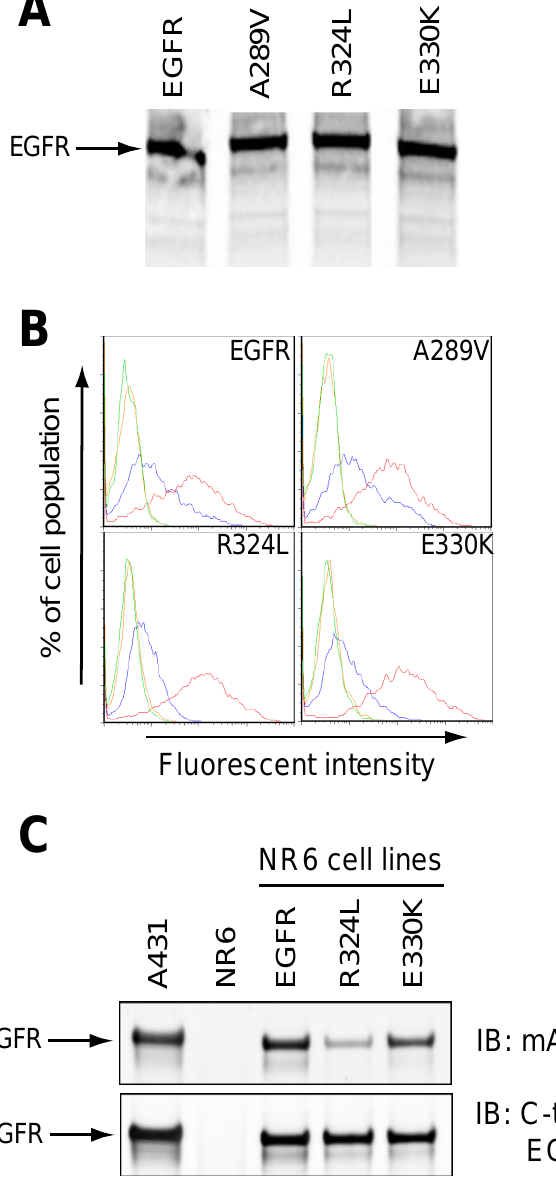
Figure 1. Biochemical characterization of mutant epidermal growth factor receptor (EGFR). ( A ). wtEGFR and mutant EGFR were translated into 35 S-cysteine labelled proteins in a cell free expression system and labeled proteins detected by autoradiography following SDS-PAGE; ( B ). NR6 cells expressing wtEGFR or mutant EGFR were stained with secondary antibody alone (green), isotype control antibody (orange), mAb528 (red) or mAb806 (blue) and subjected to Fluorescence Activated Cell Sorting ( FACS) analysis. The representative profiles for each cell line are shown; ( C ). wtEGFR or mutant EGFR cells were grown under serum free conditions, lysed and IP’d using mAb528. Western blot analysis of total EGFR using a mAb806 probe ( upper panel ) or a C-terminal EGFR probe ( lower panel ) are shown. A431 cells that overexpress the EGFR were included as a positive